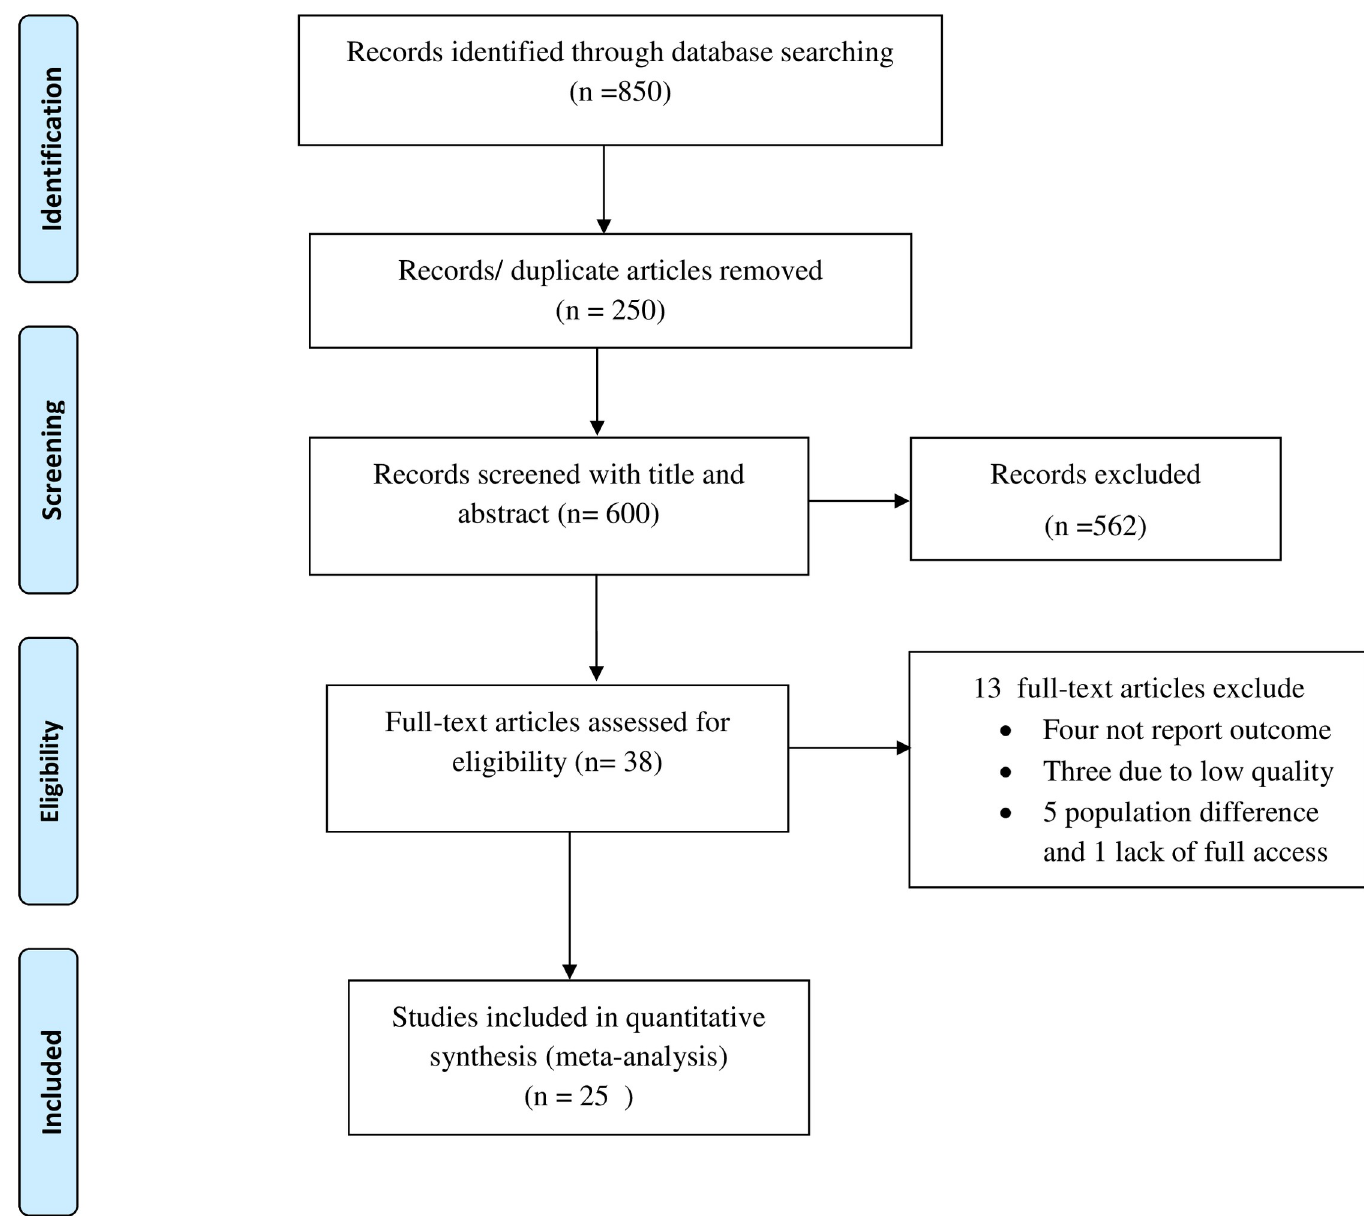
Fig 1. PRISMA flow diagram of cervical cancer screening utilization in